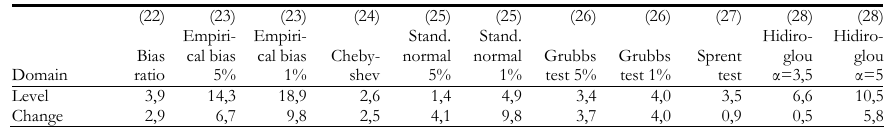
Percent absolute difference between the number of IFU units detected using formula (2) or formula (11) for the “Total retail trade”